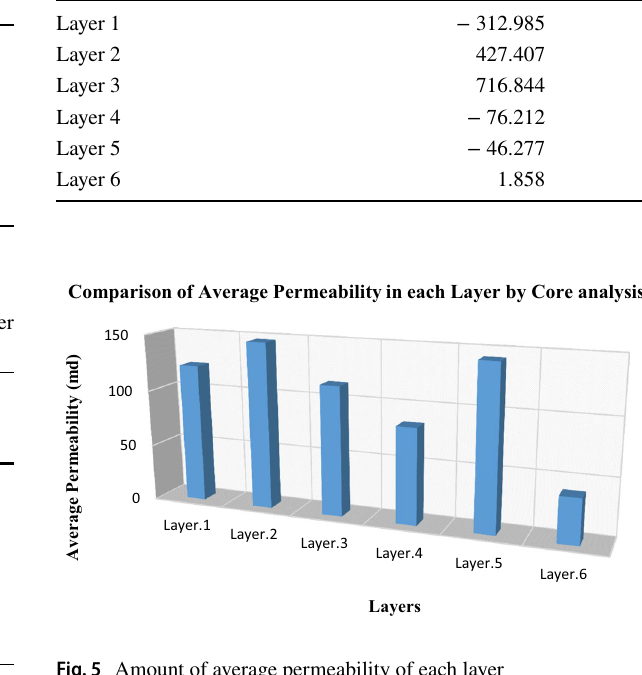
Table 5 Amount of permeability measurements by Emeraude soft- ware Layer no.